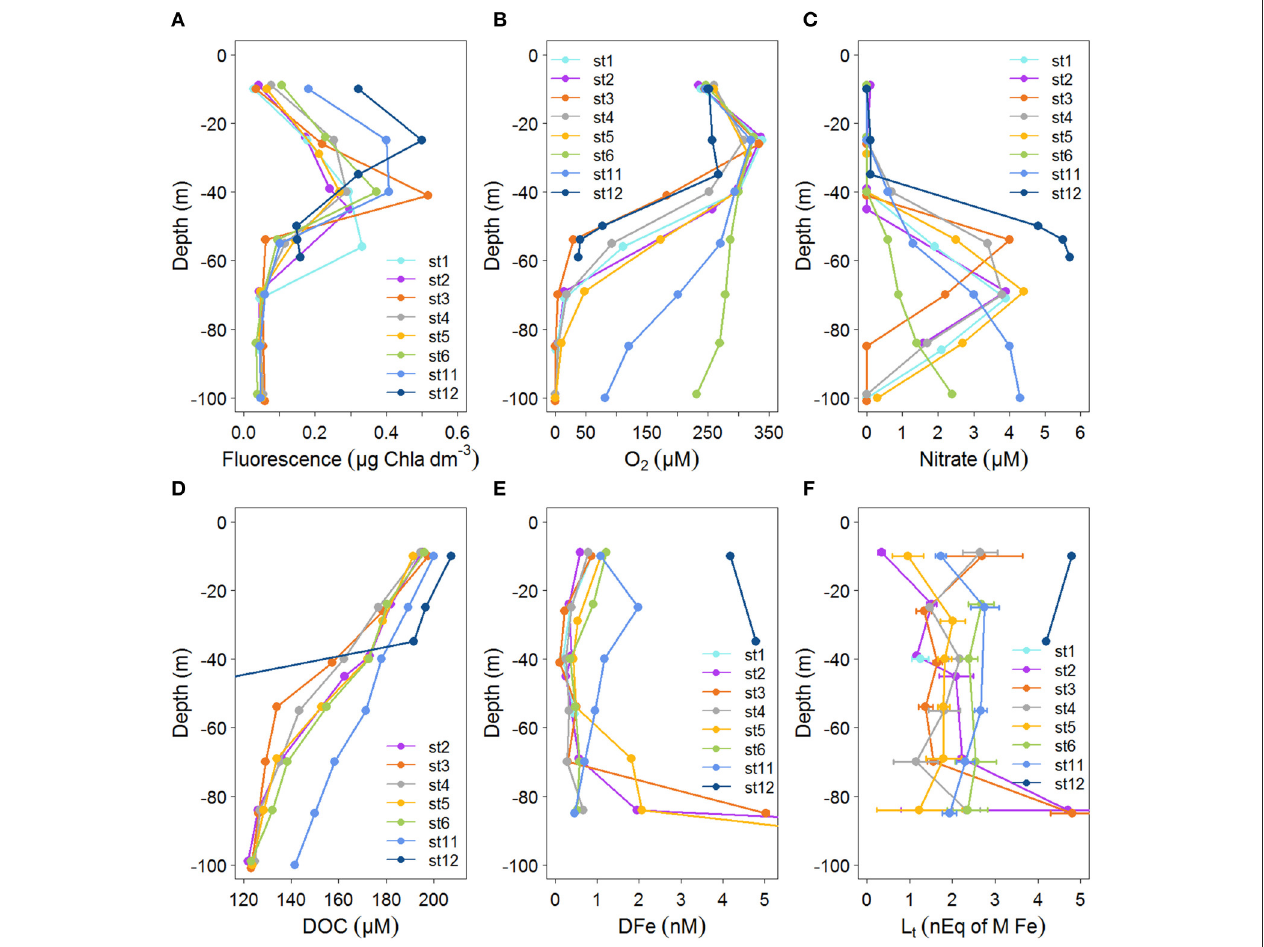
FIGURE 2 | Profiles of concentrations with depth (0–100 m) for the stations indicated in Figure 1 for: (A) Fluorescence ( µ g Chl α dm − 3 ) from calibrated CTD sensor data. (B) Oxygen concentration ( µ M) from calibrated CTD sensor data. (C) Nitrate ( µ M). (D) DOC ( µ M) from Margolin et al. (2016). DOC in station 12 at depths of 50–59 are between 78 and 90 µ M. (E) Dissolved Fe (DFe, in nM), standard errors fall within the symbols (see Table 1 ). DFe at stations 2 and 5 at 100m are outside the scale, DFe increased from 84m to 100m from 1.95 to 27.6 at station 2 and from 2.06 to 13.4 at station 5. (F) Fe-binding dissolved organic ligands, with standard errors of the fitting of the Langmuir isotherm ([L t ] in nEq of M